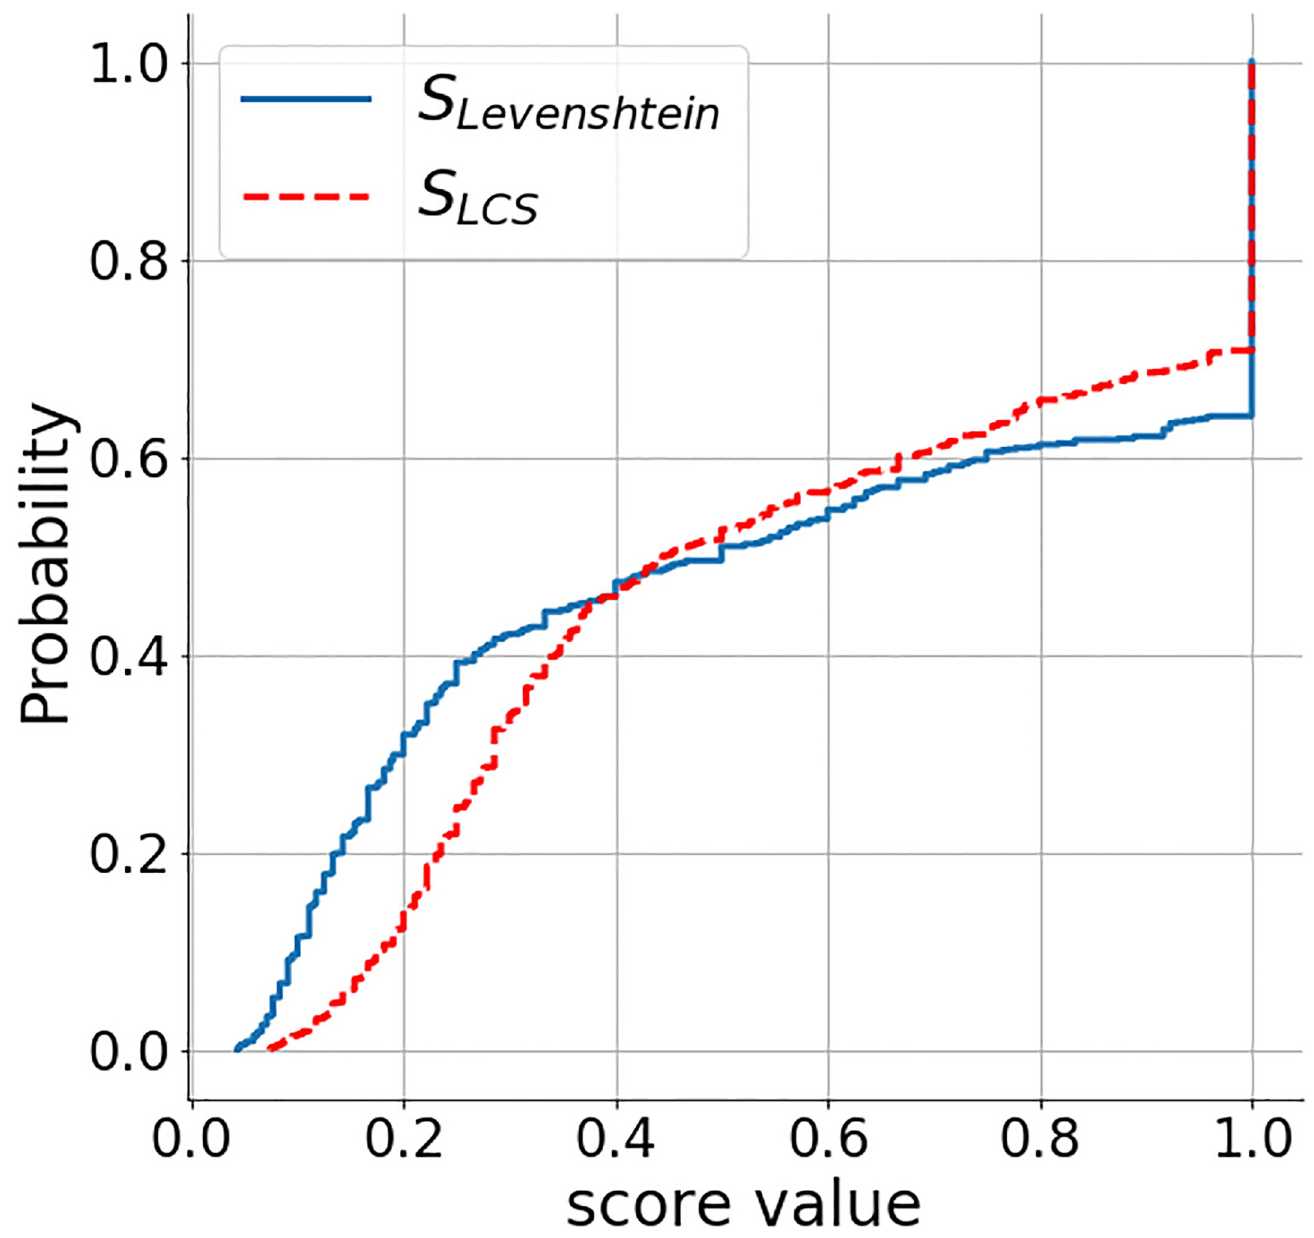
Fig 13. CDF of S